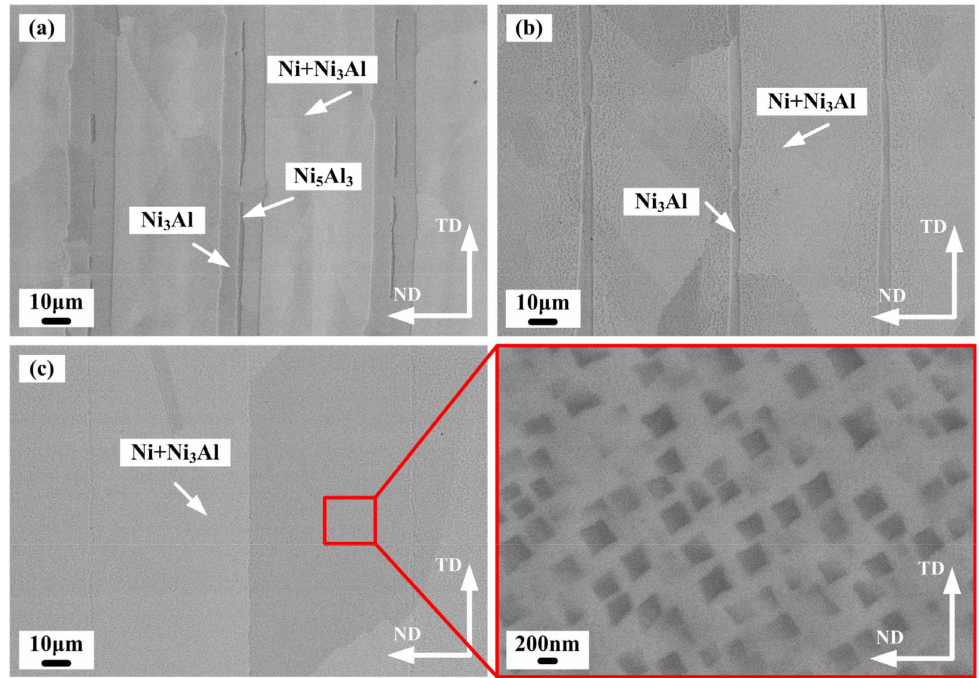
Figure 4. BSE images of the laminated composites. ( a ) N1; ( b ) N2; ( c ) N3.